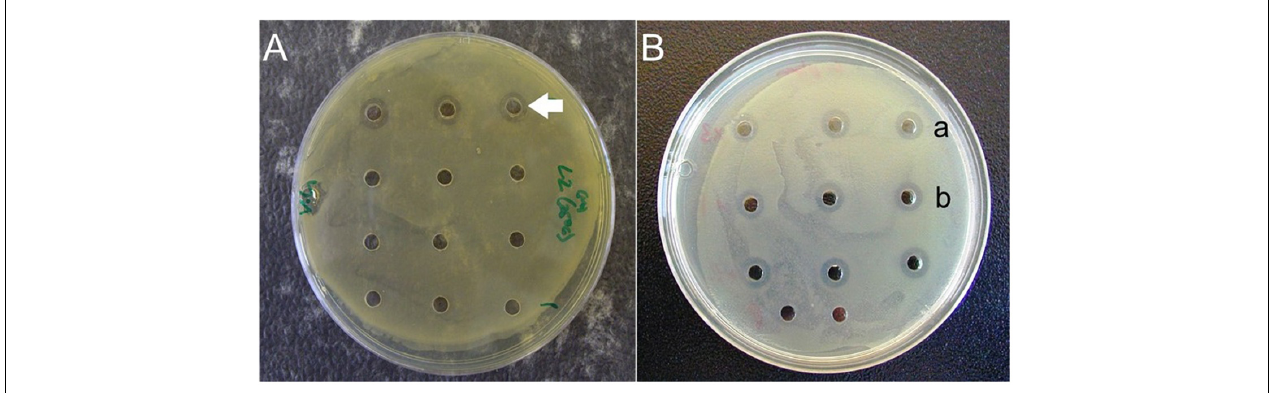
FIGURE 1 | (A) Cell-free culture supernatant antagonistic activity assay against Vibrio harveyi . Positive results observed using cell-free supernatant from Lactobacillus plantarum (unlabeled arrow). Supernatant in the remaining wells (from other isolates from shrimp GI tracts) displayed no antagonistic activity. (B). Cell-free culture supernatant antagonistic activity assay against V. alginolyticus . Positive results observed using cell-free supernatant from L. plantarum subjected to freezing/thawing (row a) and heating (row b).